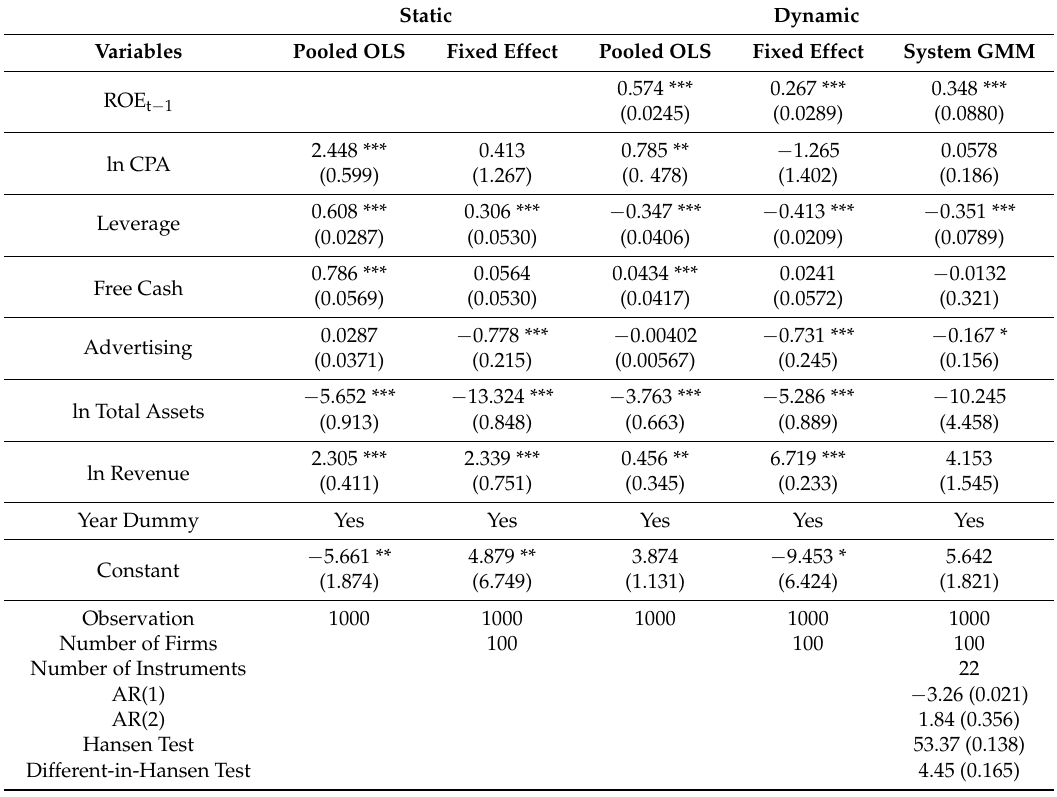
Table 5. The Impact of CPA and Firm performance (ROE).